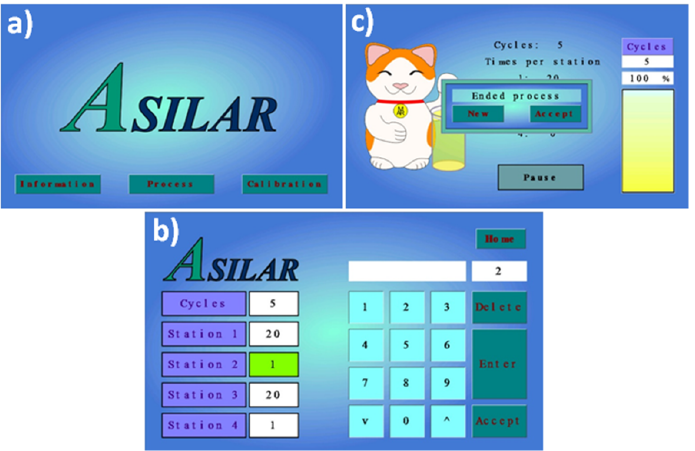
Figure 12. Home page ( a ), variables page ( b ), and process page ( c ).